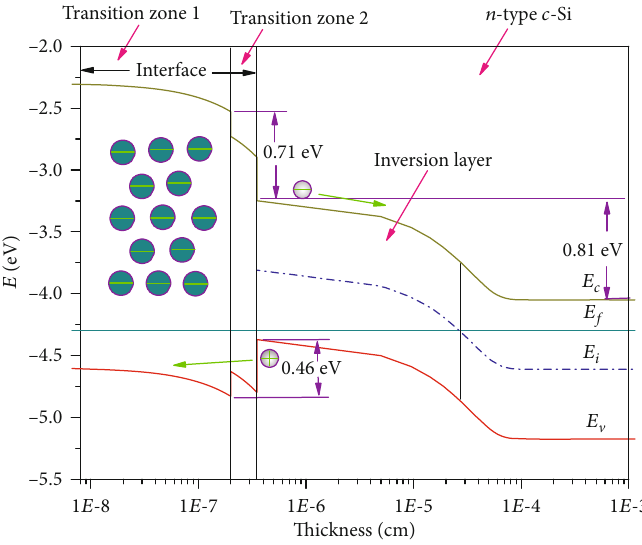
Figure 4: Energy band diagram at